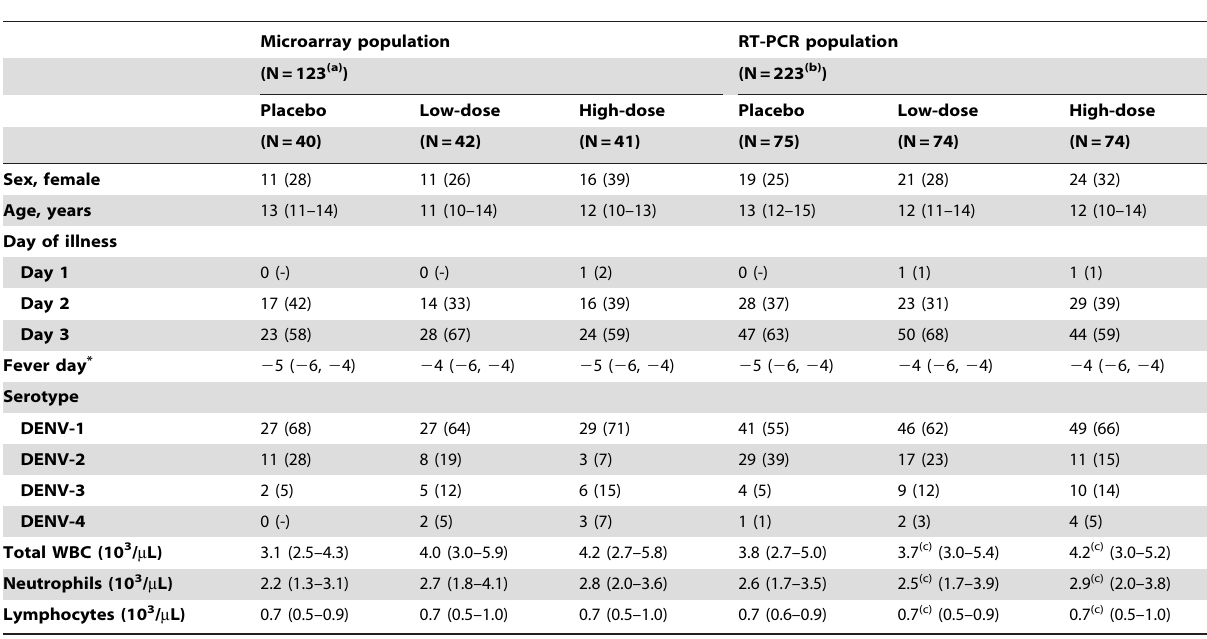
Table 1. Enrolment characteristics of patients sampled for the microarray and RT-PCR